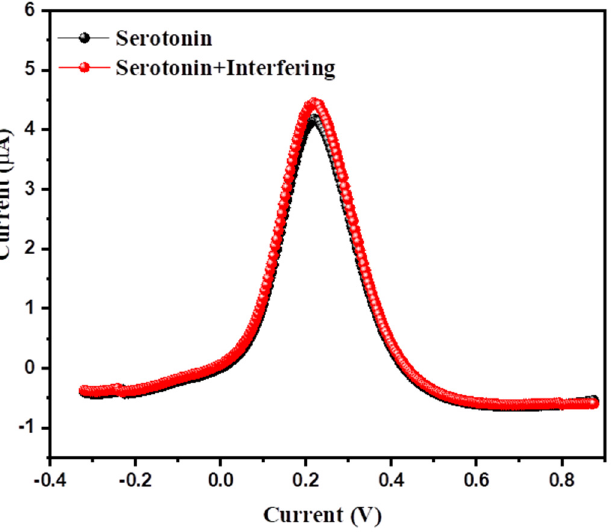
Figure 10. DPVs of MGCE in 20 µM of serotonin and serotonin + interfering species (urea, glucose, dopamine, hydroquinone, ascorbic acid) in 0.1 M PBS (pH = 7.0) at scan rate of 50 mV/s.